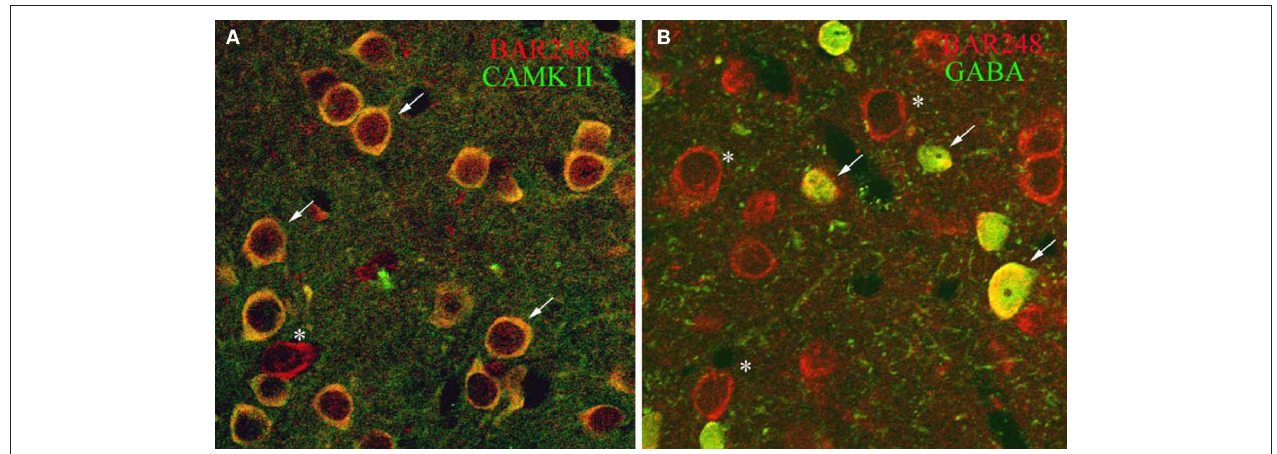
Figure 2 | Confocal micrographs show that β Ar 248 is localized to both excitatory and inhibitory LA cells. (A) Cells immunopositive for CAMKII (green) are also immunoreactive for β AR 248 (red). Arrows point to dually labeled cells